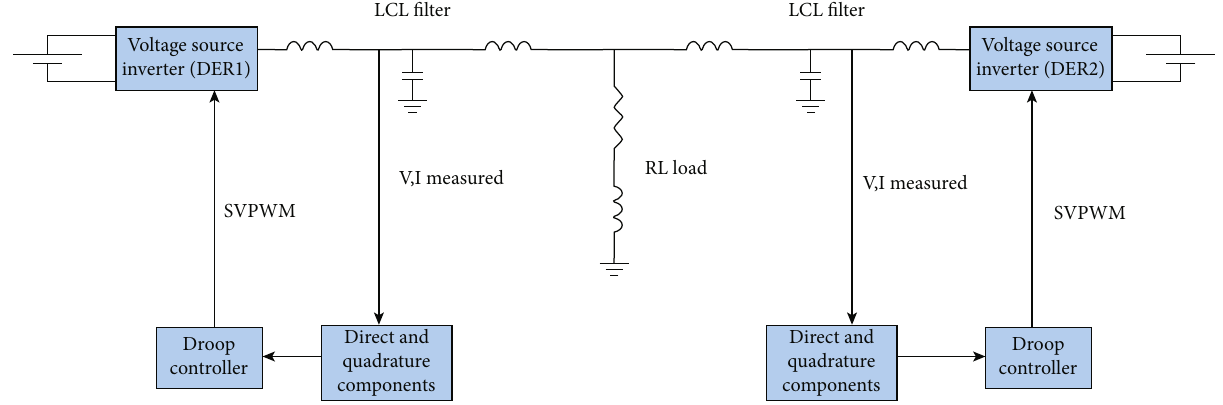
Figure 2: Droop controller overall block diagram.